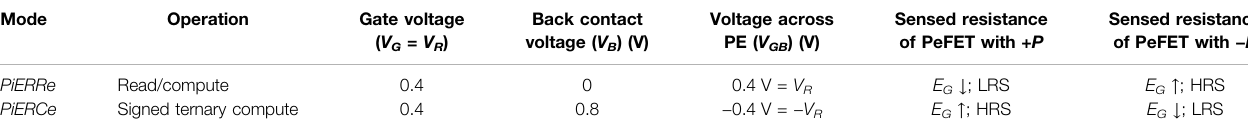
TABLE 2 | Summary of bias conditions and the PeFET resistance state with PiERRe and PiERCe